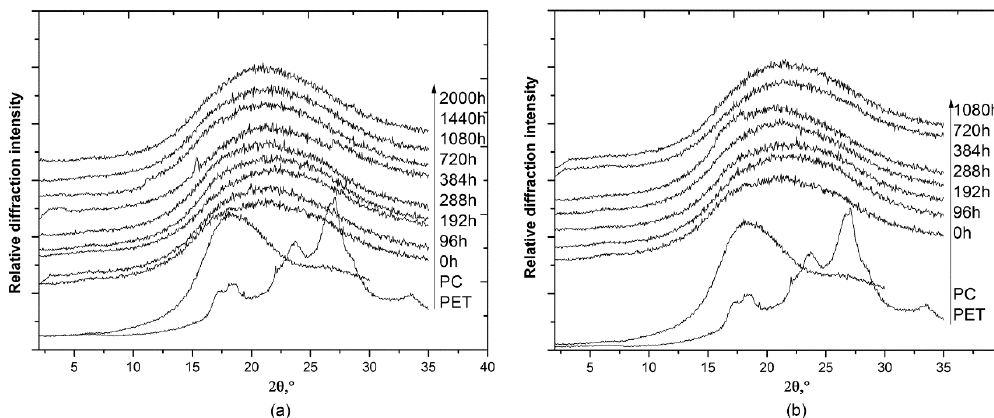
Figure 1. WAXD curves of the PET/PC blends, exposed to (a) natural aging and (b) accelerated